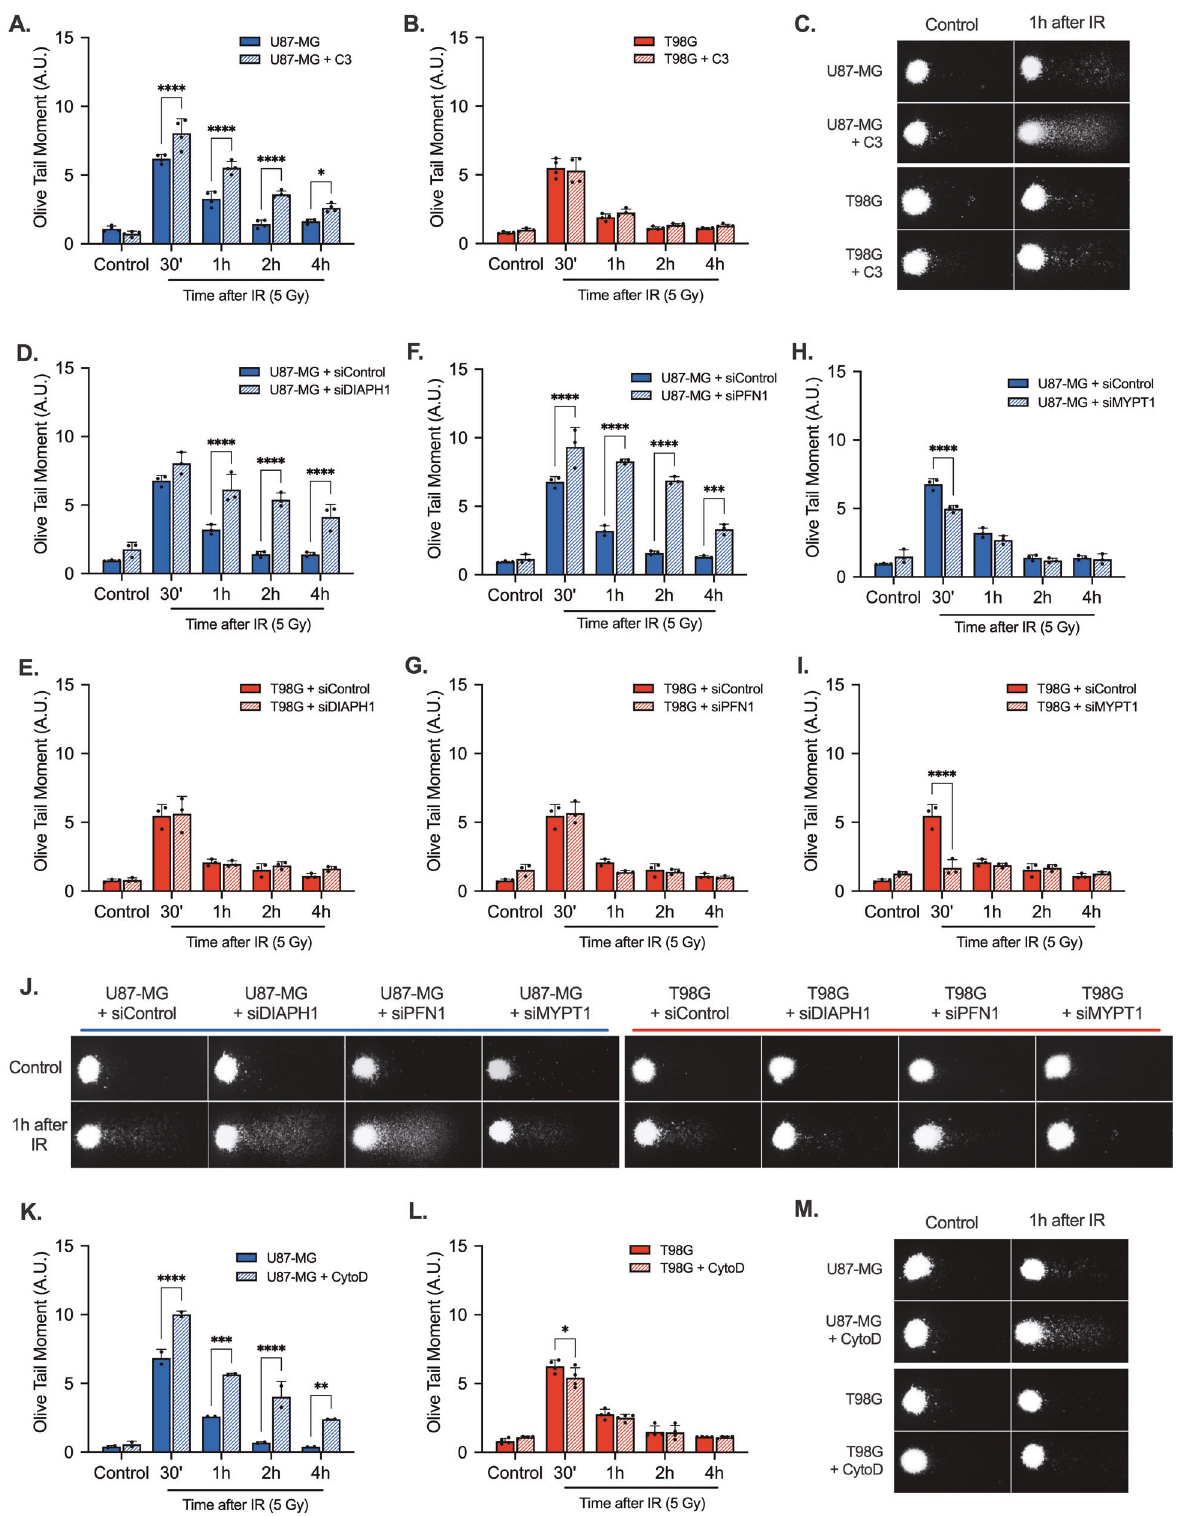
Fig. 2 Downregulation of the Rho pathway reduces the repair of DNA damage caused by IR in wild-type p53 glioma cells. Comet assays of U87-MG ( A ) and T98G ( B ) cells with Rho inhibition induced by C3 toxin treatment and IR-induced DNA damage; DNA repair is impaired by C3 toxin treatment in wild-type p53 cells but not in mutant p53 cells. Comet assays of GBM cells exposed to IR after knockdown of DIAPH1 ( D , U87-MG and E , T98G) or PFN1 ( F , U87-MG and G , T98G) indicate decreased DNA repair and persistent DNA fragmentation for up to 4h after IR stress, but only in U87-MG cells. Conversely, MYPT1 knockdown ( H , U87-MG and I ) leads to higher resistance to IR in both cell lines, as indicated by the decreased DNA fragmentation after IR. Comet assays of U87-MG ( K ) and T98G ( L ) cells subjected to inhibition of F-actin polymerization with CytoD treatment show increased DNA fragmentation after IR stress only in wild-type p53 cells and not in T98G cells. Representative images of comet tail relative to the 1-h time point after IR ( C , J , and M ). The graphs show the mean ±SD of three or four independent experiments, with the averages of individual biological replicate dots from the analysis of DNA fragmentation in 100 independent nuclei by two-way ANOVA with Sidak ’ s multiple comparison test. Cell Death and Disease (2023)